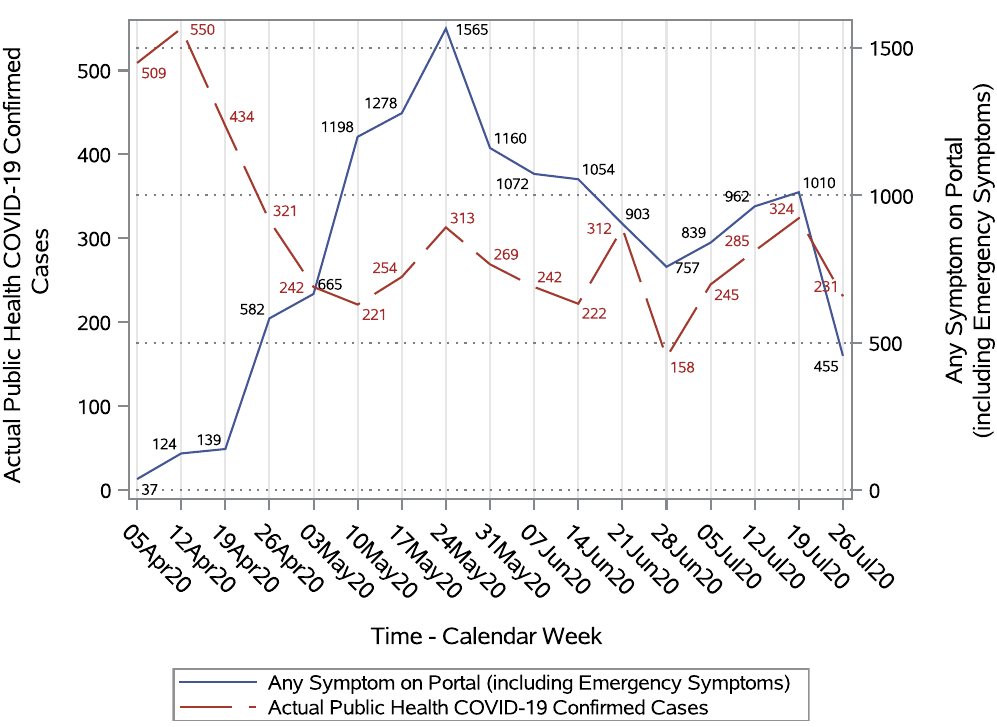
Figure 3. Trend in number of respondents with COVID-19 symptoms versus actual diagnosed COVID-19 cases.